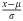
Structural entropy plot for the HIV-1 genome (GenBank AF033819.3).UsingRNAentropy, the structural entropy was computed for each 100 nt portion of the HIV-1 genome, by increments of 10 nt; i.e. for 100 nt windows starting at genome position 1, 11, 21, etc. To smooth the curve, moving averages were computed over five successive windows. (A) Dotted-line displays moving average values of structural entropy; solid curve displays entropy Z-scores, defined by x-μσ, where x represents the (moving window average) entropy at a genomic position, and μ [resp. σ] represents the mean [resp. standard deviation] of the entropy for 100 nt windows. Some of the lowest entropy Z-scores are -2.69 at position 4060, -2.46 at position 8700, -1.95 at position 4040. (B) NCBI graphics display of the HIV-1 genome, for comparison purposes. Low entropy (negative Z-score) regions do not appear to correspond with the start/stop location for annotated genes. In data not shown, we also computed positional entropy values [21] for the same windows, and determined a Pearson correlation of 0.7025 [resp. Spearman correlation of 0.6829] between (moving window average) values of entropy and positional entropy.